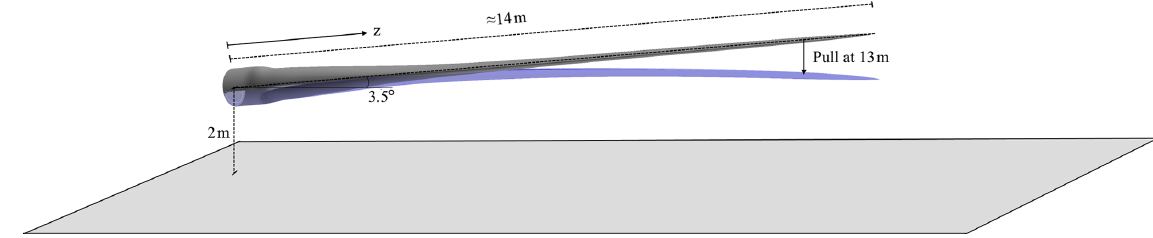
Figure 1. Setup for the pull–release test and simulation.